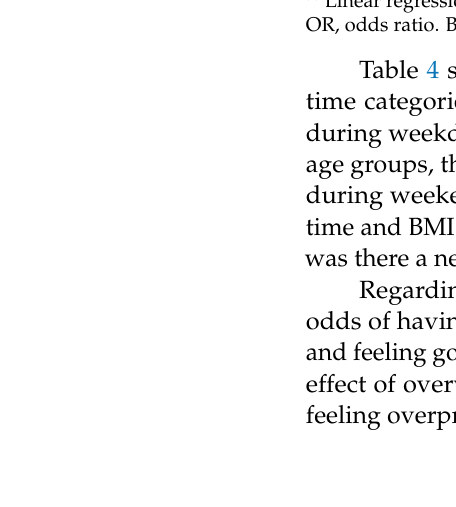
Table 4 shows the analysis of covariance for BMI z-score according to total screen time categories. Negative and significant associations were found for night-time